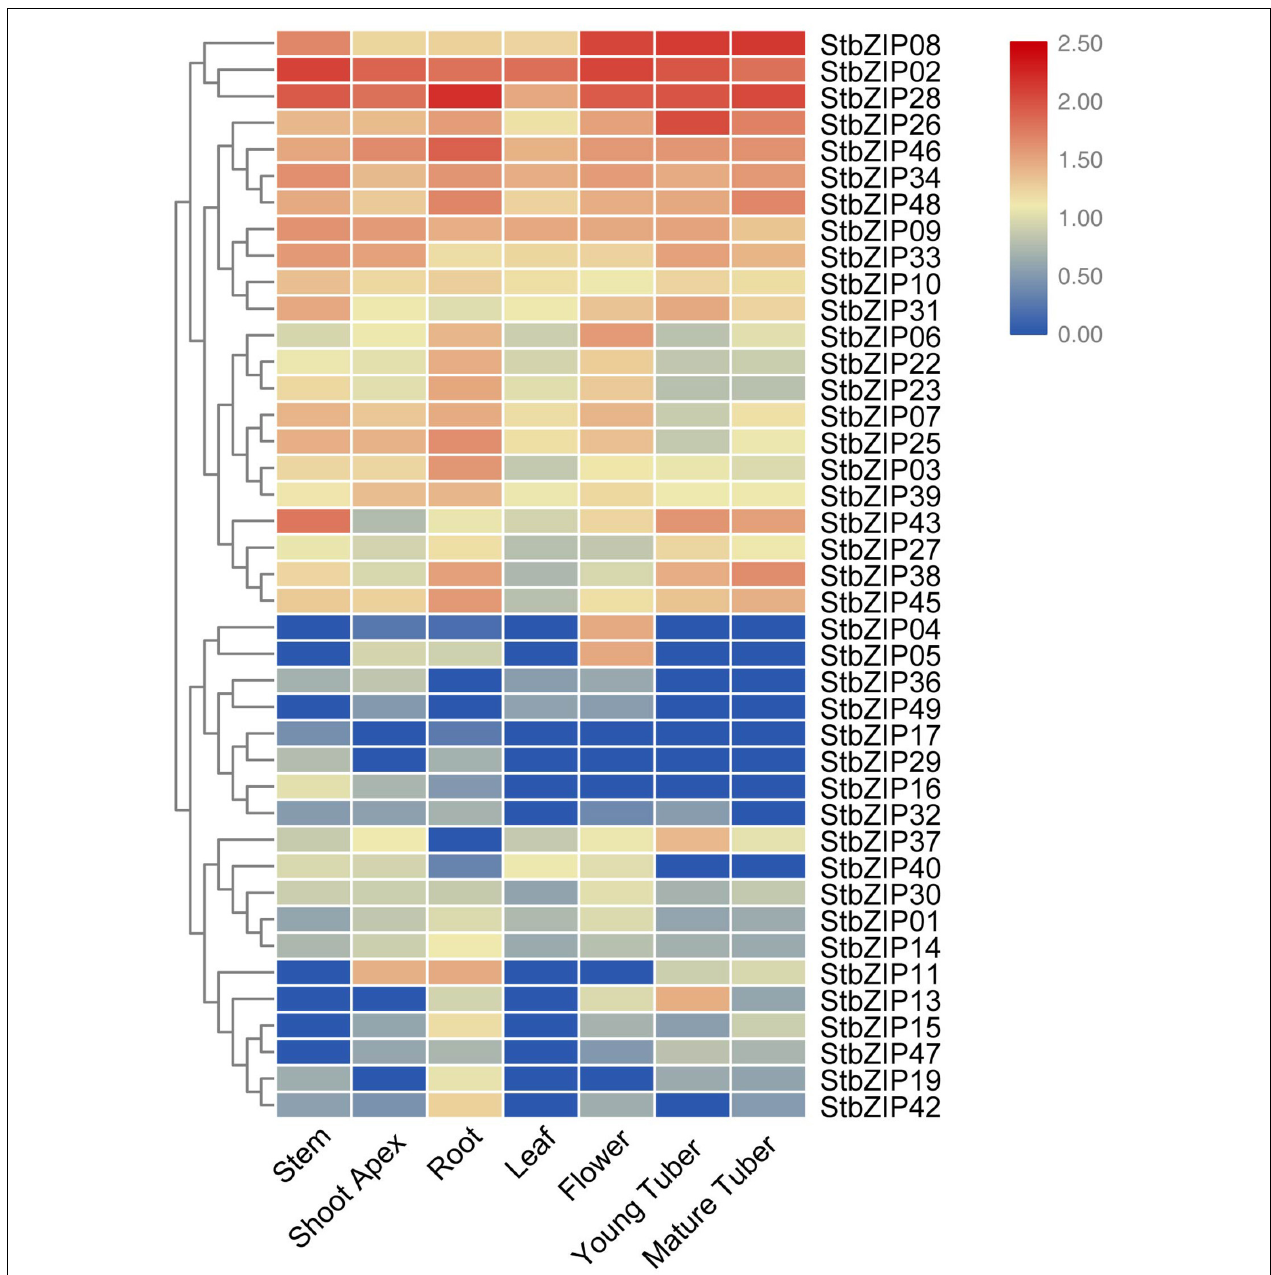
FIGURE 6 | Expression patterns of the StbZIP genes in the tested tissues. The expression pattern data were retrieved from transcriptome data and visualized by TBtools.